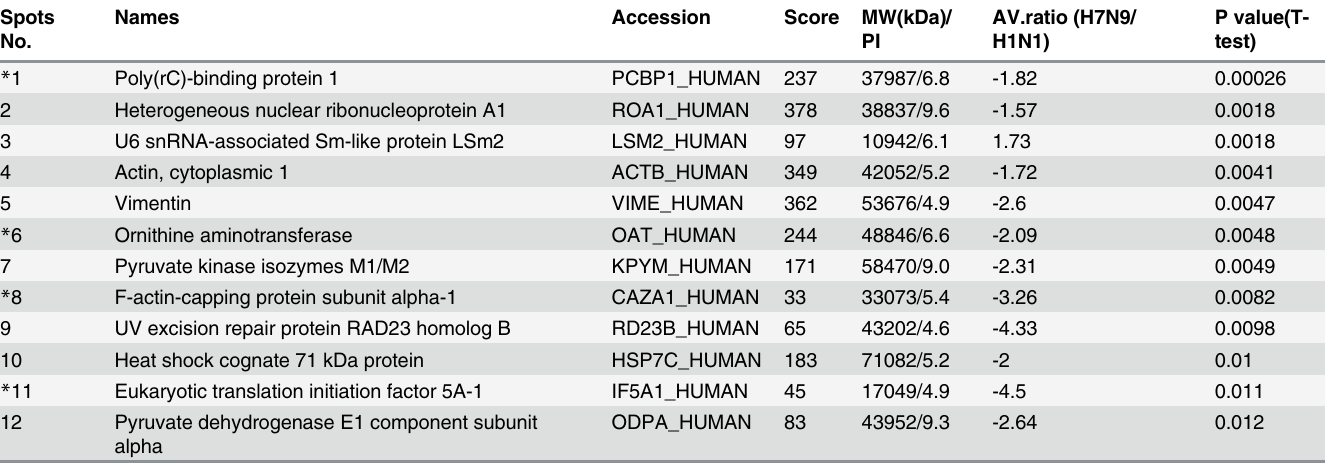
Table 2. Identification of differentially expressed proteins in A549 cells infected with H7N9 and H1N1pdm09 influenza virus at 48hpi. Spots